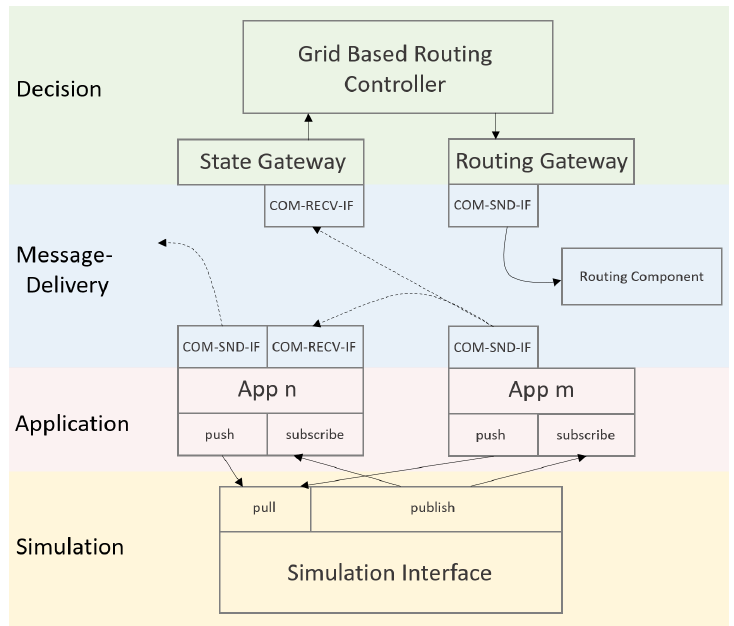
Figure 7. Architecture: Overview of the top level